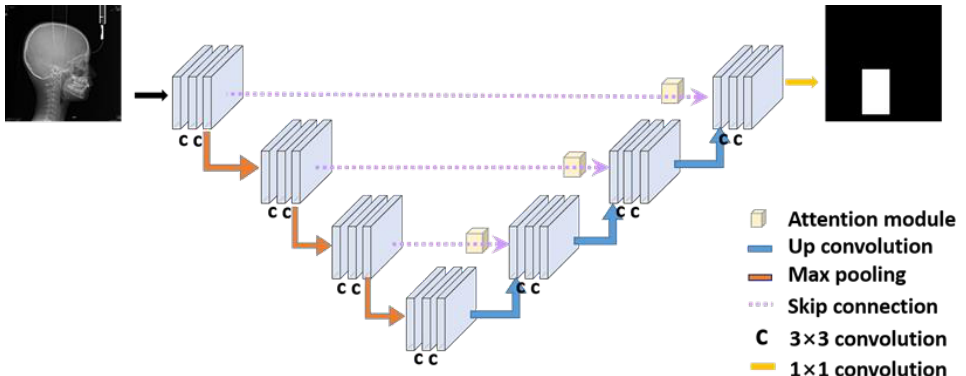
Figure 2. The architecture of the ROI detector module. The original X-ray image is an input in this module, and the output is an ROI binary image. The main network is attention U-Net.